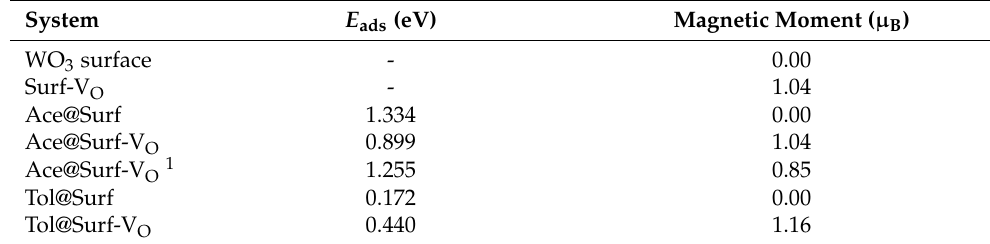
Table 1. Adsorption energies of the considered systems and their spin polarization.